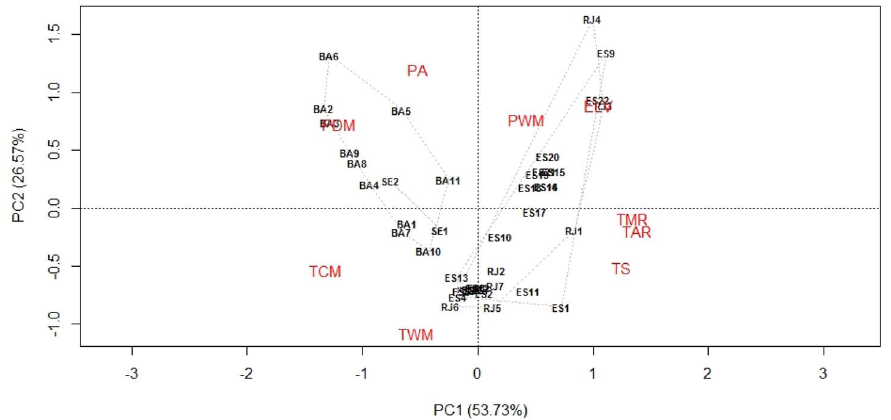
Figure 5. Projection of the nine environmental variables and the maned sloth points records on the first and second factor planes. Principal component analysis (PCA) of the association of the maned sloth points records and the nine environmental variables used in the distribution modelling procedure. Sergipe (SE), Bahia (BA), Espı´rito Santo (ES), Rio de Janeiro (RJ). Elevation (ELV), mean monthly temperature range (TMR), temperature seasonality (TS), maximum temperature of warmest month (TWM), minimum temperature of coldest month (TCM), temperature annual range (TAR), annual precipitation (PA), precipitation of wettest month (PWM) and precipitation of driest month (PDM). Points records localities are available (Table